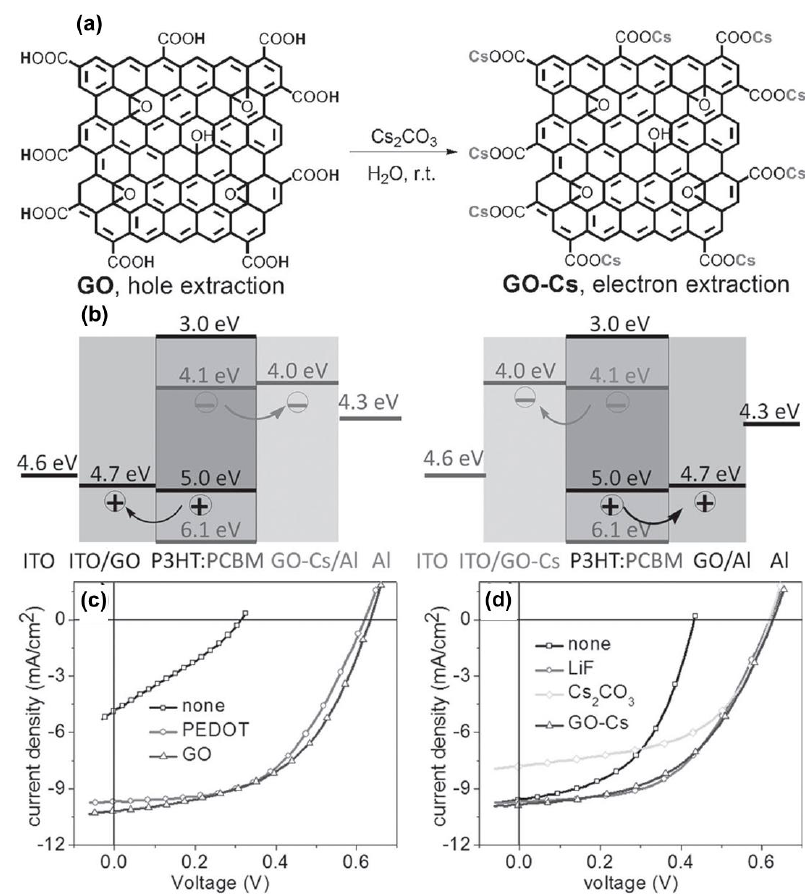
Figure 7. ( a ) Chemical structure and synthetic route of GO and GO-Cs. ( b ) Band diagram of normal and inverted soar cells using GO and GO-Cs as HTLs and electron transport layer (ETLs). ( c , d ) Performance of polymer with various HTLs and ETLs. Reproduced with permission [96] .